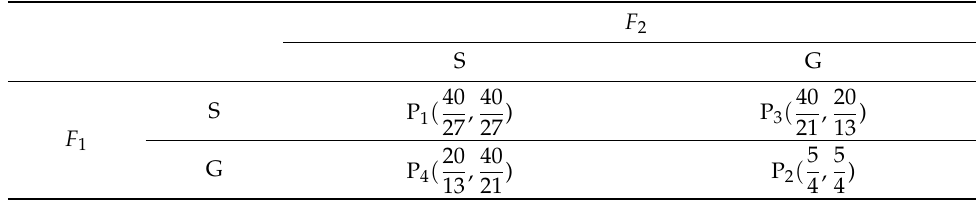
Table 3. Value of game profit matrix.